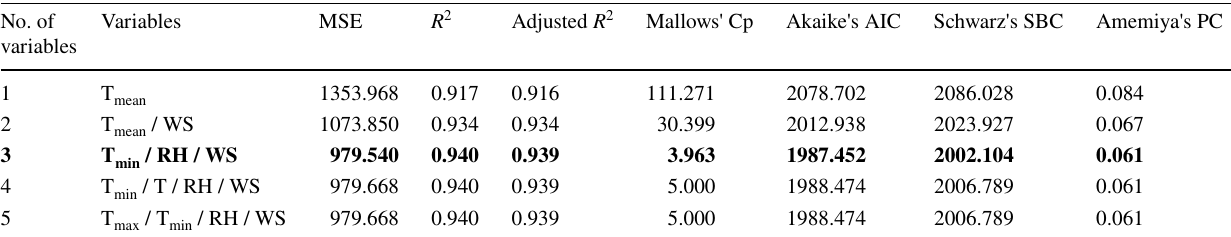
The best model for the selected selection criterion is displayed in green